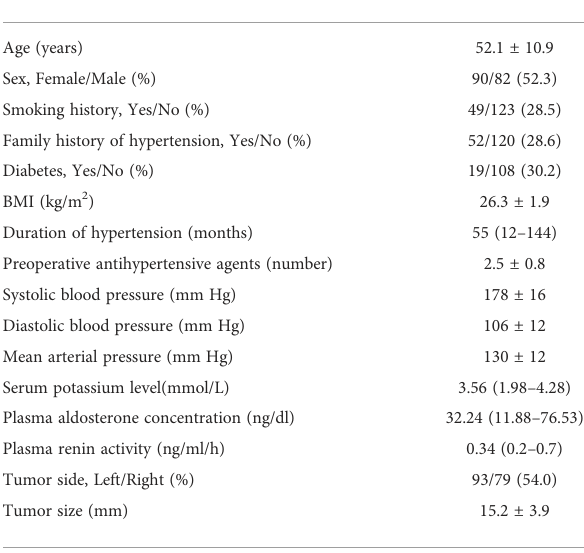
TABLE 1 The patient ’ s